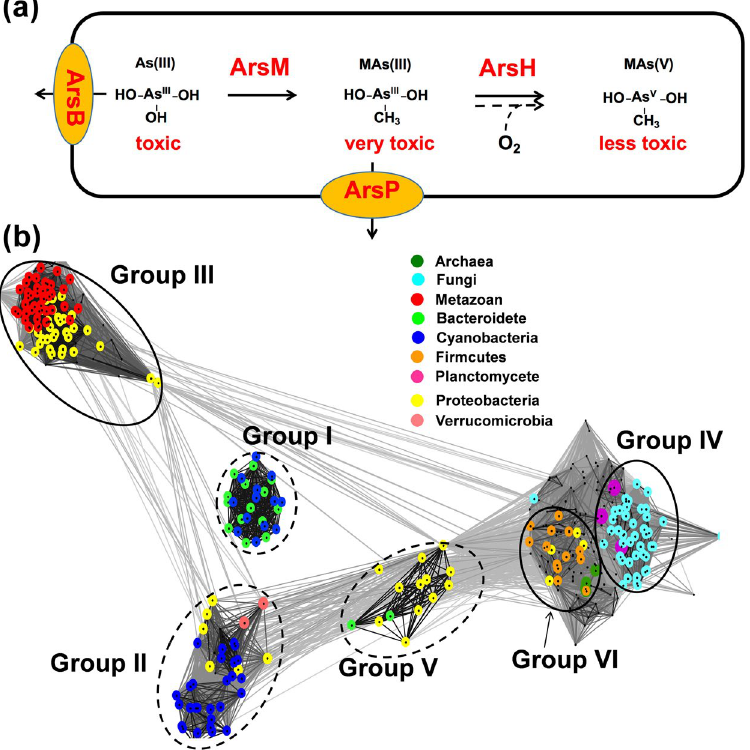
Figure 1. ( a ) Diagram representing enzymatic reactions catalyzed by arsenite efflux permease (ArsB), arsenite methyltransferase (ArsM), organoarsenical oxidase (ArsH) and methylarsenite efflux permease (ArsP). As(III): arsenite, MAs(III): methylarsenite, MAs(V): methylarsenate; ( b ) Cluster map of As(III) SAM methyltransferases (ArsM). Protein sequences of ArsM orthologs were clustered based on their pairwise similarity using the CLANS program (Frickey and Lupas, 2004). The clans containing sequences from more than one kingdom of life are indicated by black circles. Clans containing arsM from different phylums of bacteria are indicated by dash